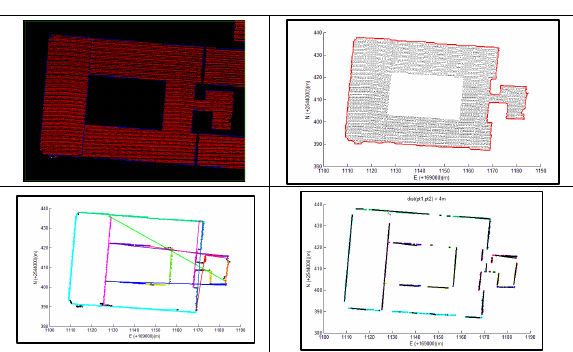
Figure 15. Test results of building 3.